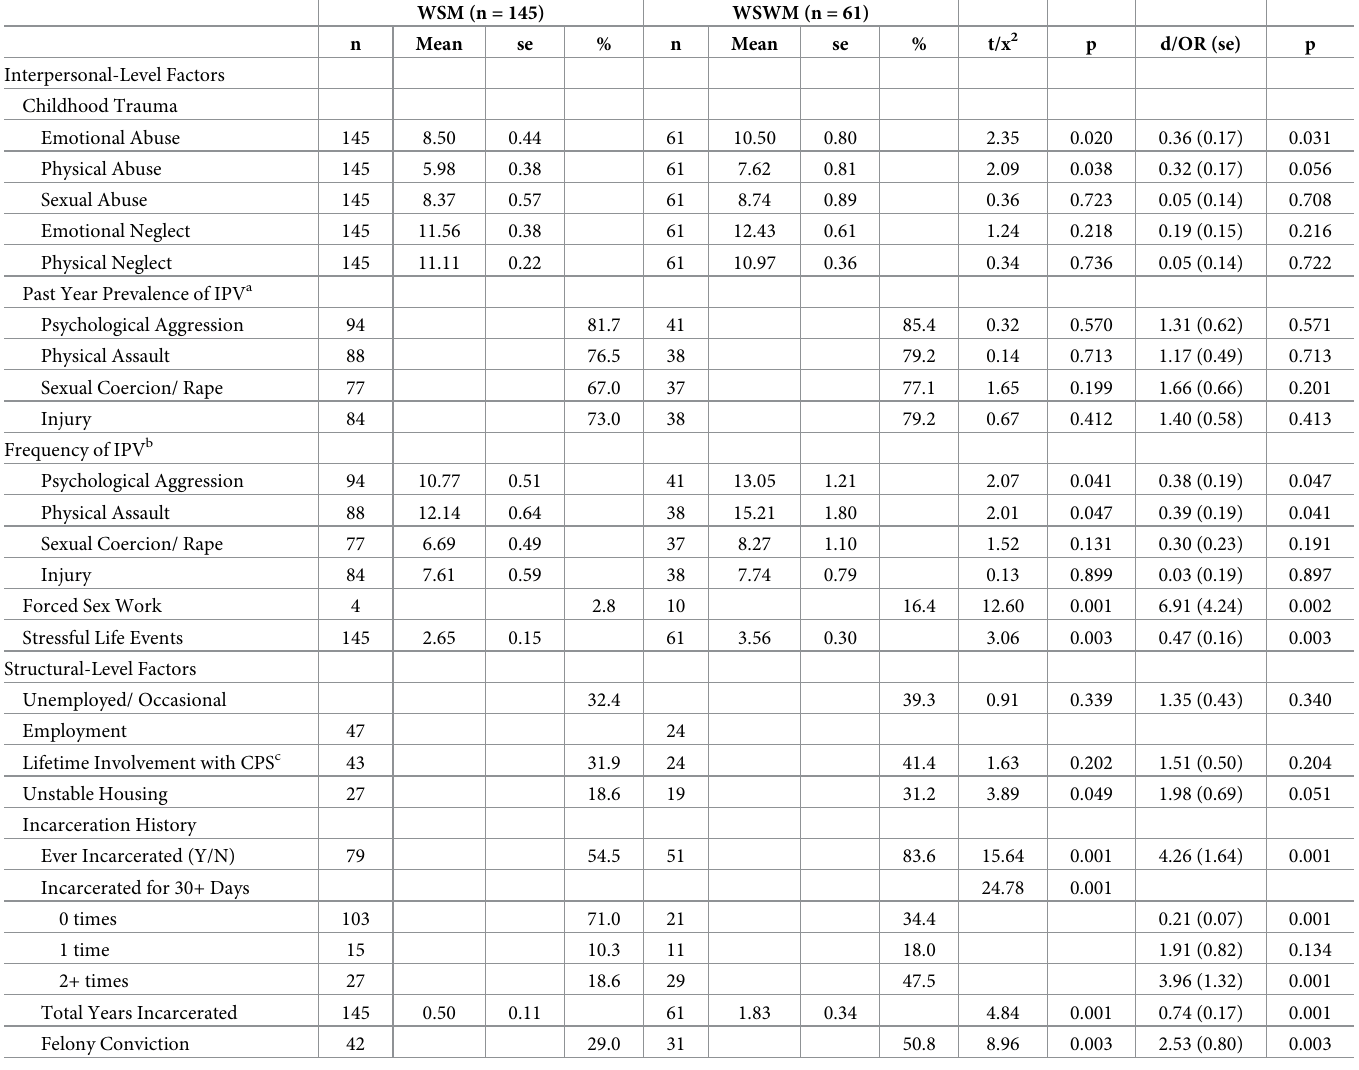
Table 2. Differences in interpersonal-level and structural-level factors between Women who have Sex with Men (WSM) and Women who have Sex with Women and Men (WSWM) in proyecto